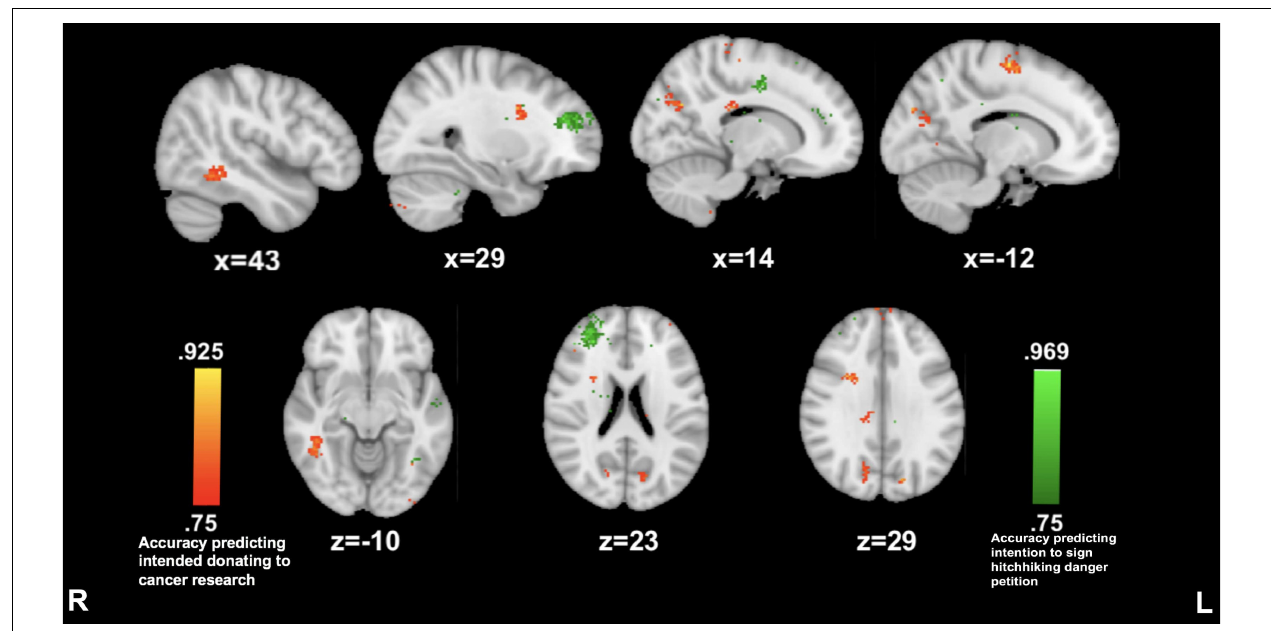
FIGURE 5 | Anterior insula connectivity predictive of prosocial intention during The Hitcher . MVPA searchlights showing above chance classification of AI connectivity maps for high vs. low prosocial intention for related (red) vs. unrelated (green) issues during The Hitcher.